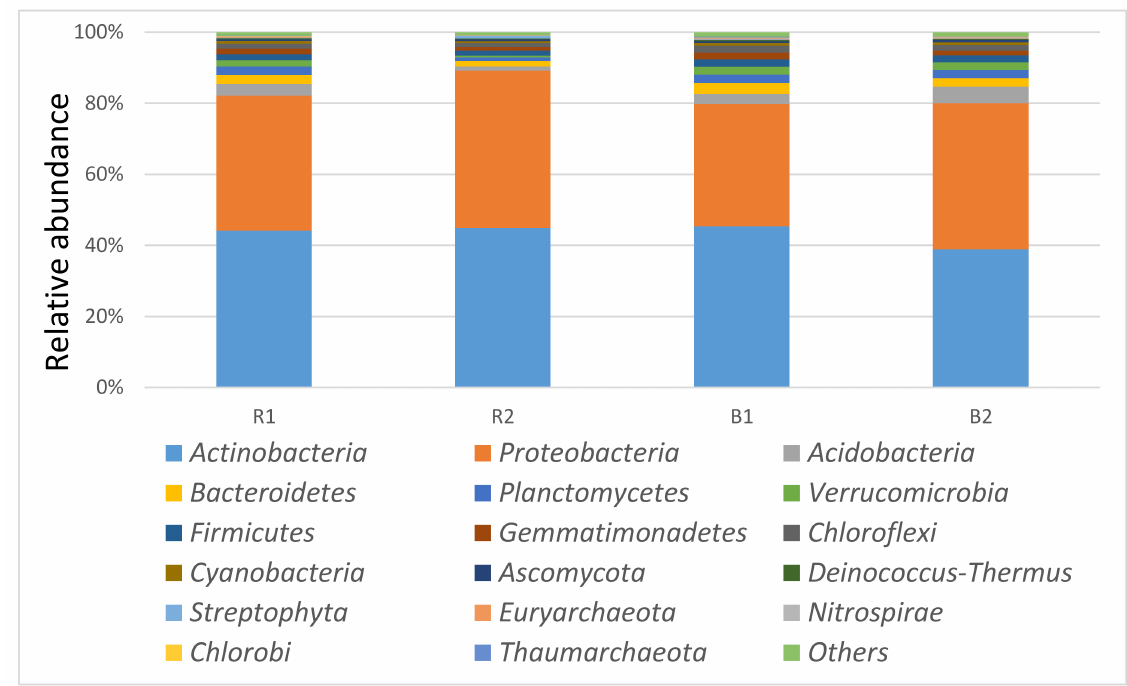
Figure 3. Classification of the most abundant phyla observed using shotgun metagenomic sequences in the rhizosphere (R1 and R2) and bulk soil samples (B1 and B2) of two sunflower fields in South Africa, Palmietfontein (R1, B1) and Bloemhof (R2,